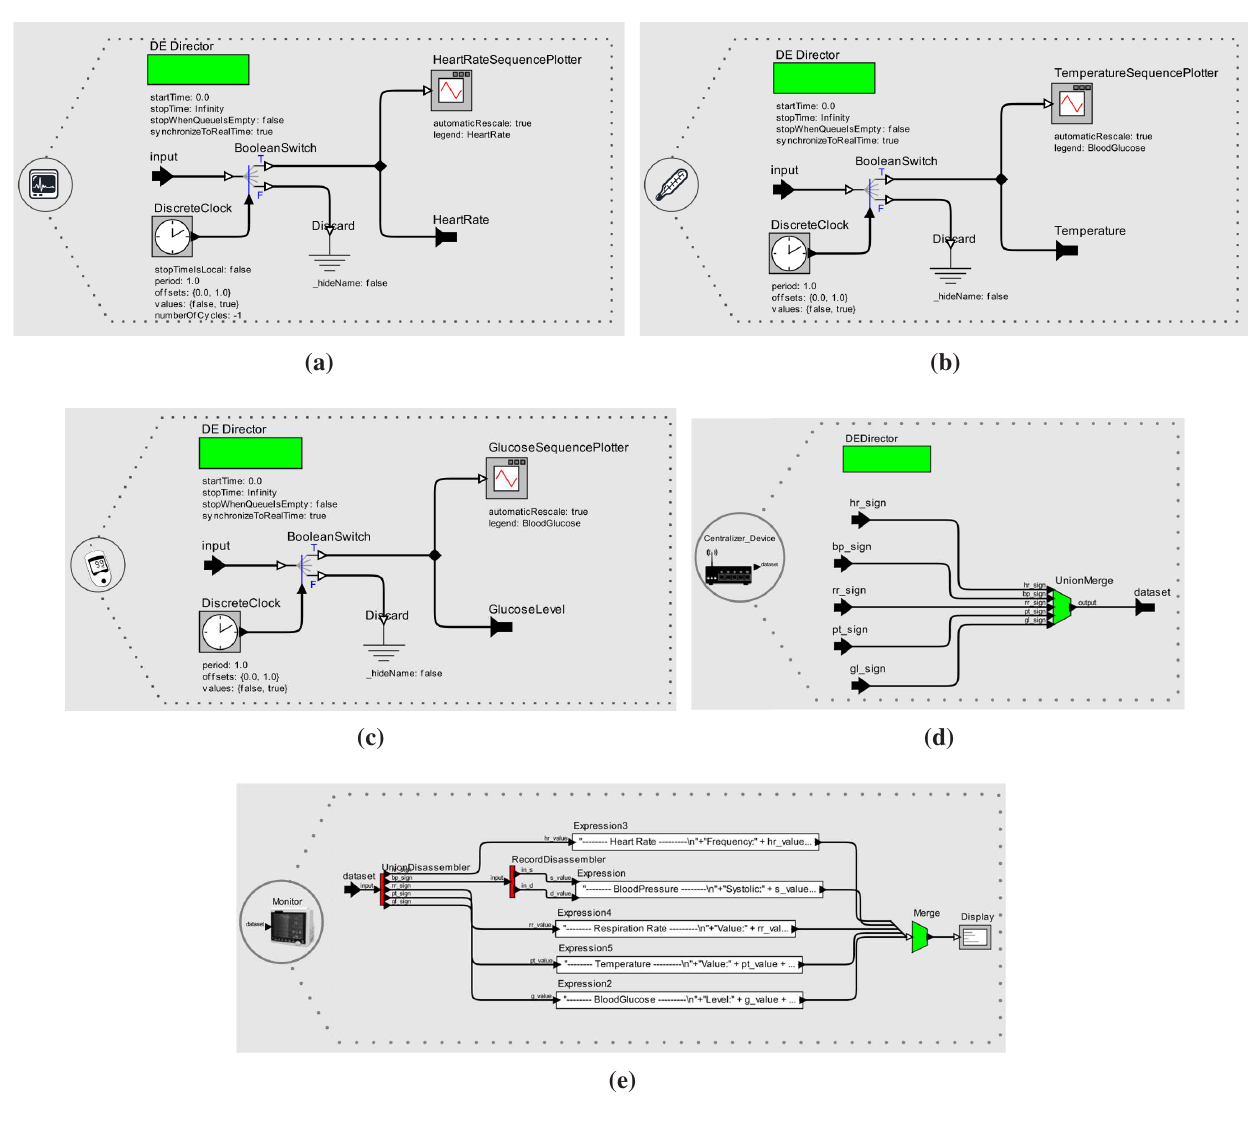
Figure 12. User Library. ( a ) Device Model for Cardiac Monitor; ( b ) Device Model for Thermometer; ( c ) Device Model for Glucometer; ( d ) Device Model for Data Centralizer; ( e ) Device Model for Bedside